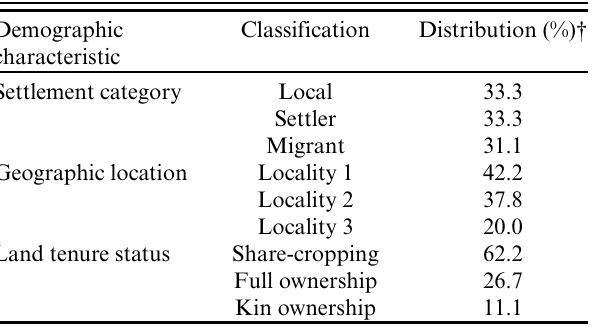
Table 1. Respondent demographic data for the study area, Sunyani District, Brong Ahafo Region,